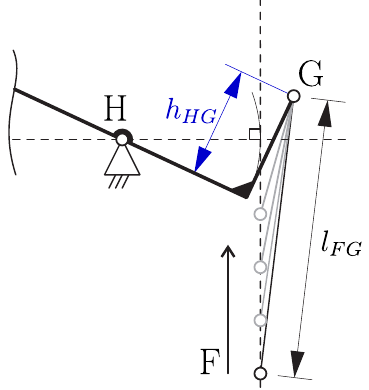
Figure 6. Visualization of the angles of the coupling element for a deflected state of the weighing cell. The adjustment parameter h HG is kept constant. If joint F is shifted upwards, the stiffness reduction effect of the parameter h HG is decreased.